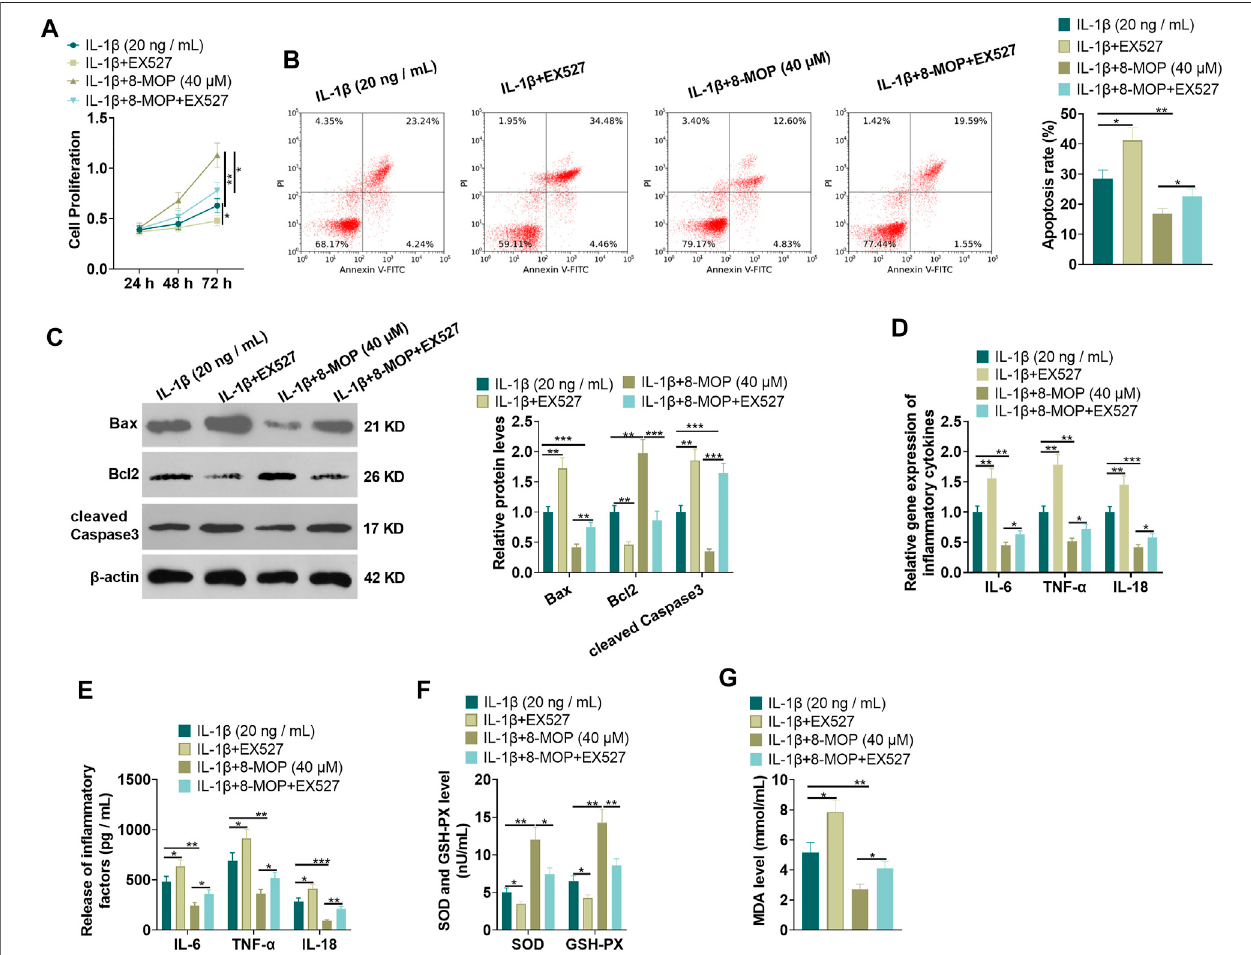
FIGURE 4 | Inhibition of SIRT1 weakened the protective effect of 8-MOP on chondrocytes. On the basis of IL-1 β stimulation, the chondrocytes were dealt with 8- MOP (40 μ M) and/or EX527 (20 μ M) for 24 h. (A – B) , MTT and FCM were adopted to de fi ne cell proliferation and apoptosis, respectively. (C) . The expression of Bax, Bcl2,andcleaved Caspase3wascheckedbyWesternblot. (D – E) .Thelevelsofin fl ammatorycytokines (IL-6,TNF- α ,and IL-18)weredetected byqRT-PCRand ELISA. (F – G) :Theoxidativestressfactors(MDA,SOD,andGSH-PX)inchondrocytesweremeasuredbytheMDA,SOD,andGSH-PXdetectionkits.* p < 0.05,** p < 0.01, *** p < 0.001. ( n (cid:1)